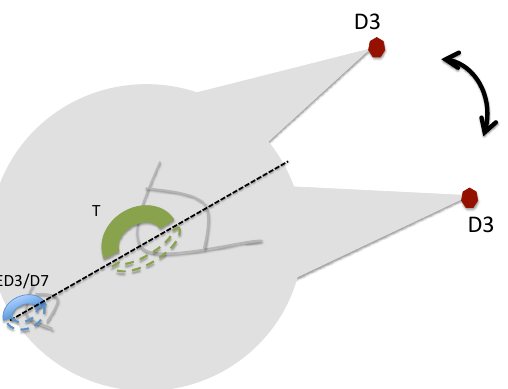
Figure 1 . Global embedding of a local oriented quiver coming from fractional D3 branes at singularities. The action of the orientifold involution is represented by the dashed line. The in- volution exchanges two identical quivers. An additional del Pezzo divisor can support either an ED3-instanton or a D7 stack with gaugino condensation. Due to the presence of non-zero gauge (cid:13)uxes, the large four-cycle tends to be wrapped by a hidden D7 stack (T-brane) which is responsible for a dS